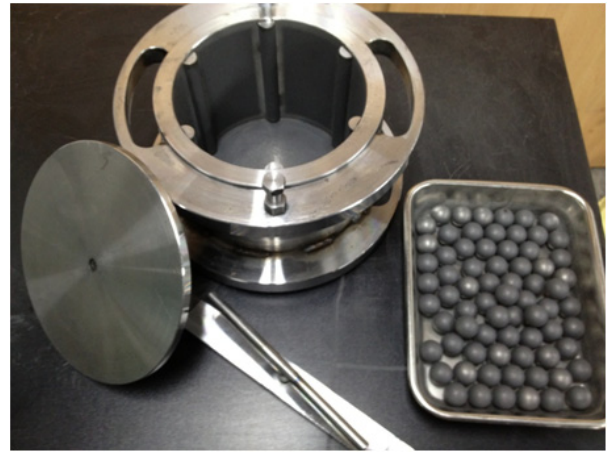
Figure 1. Laboratory-scale ball mill used for SSFBTs.